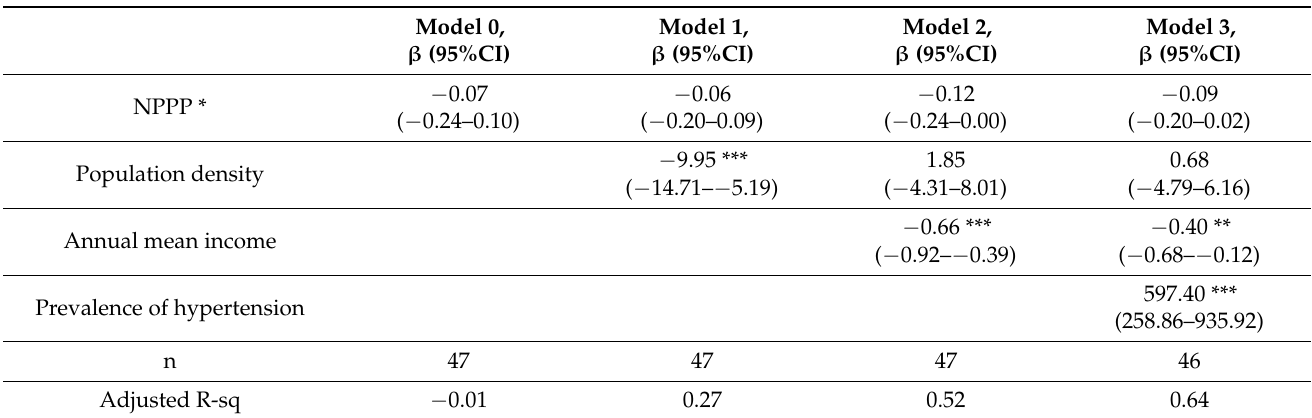
Table 3. The association between the number of physicians per 100,000 people (NPPP) and the CeVD death rate.